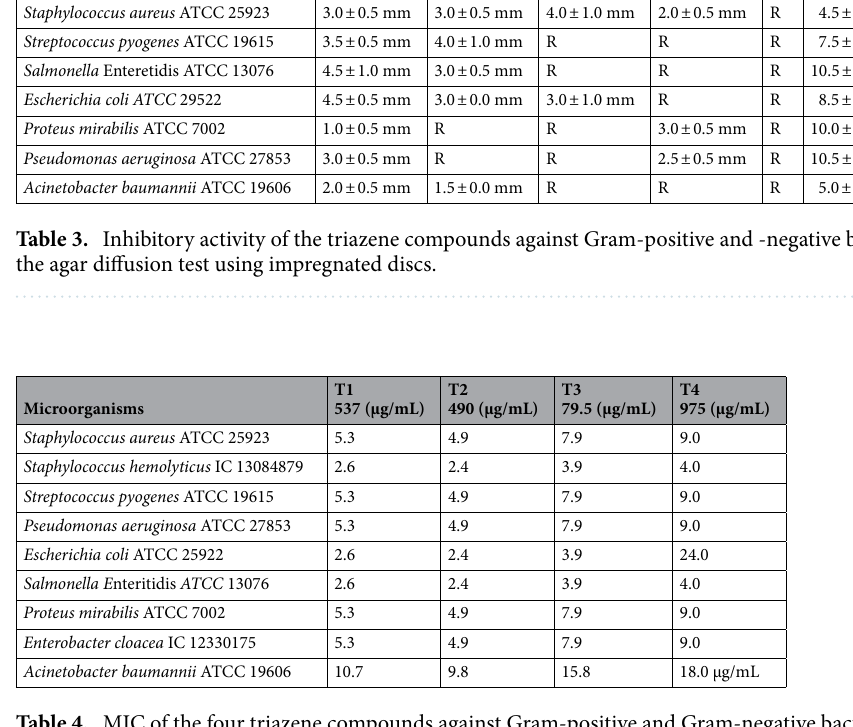
Table 4. MIC of the four triazene compounds against Gram-positive and Gram-negative bacteria.